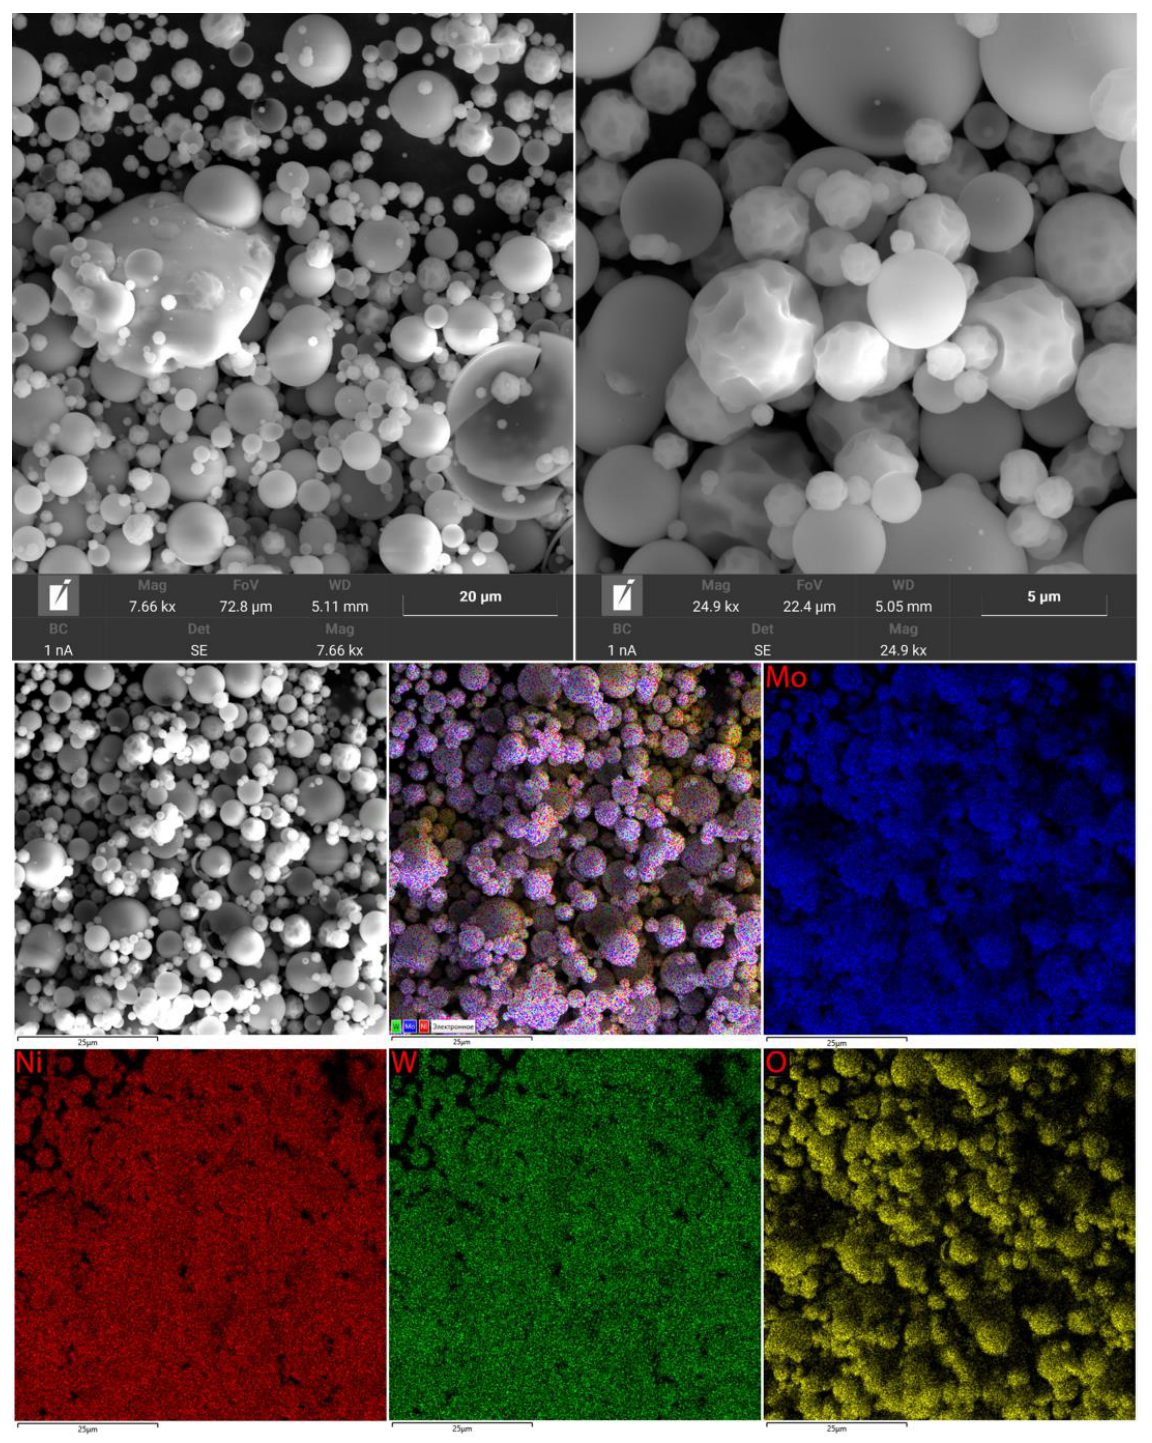
◦ C) catalyst at different